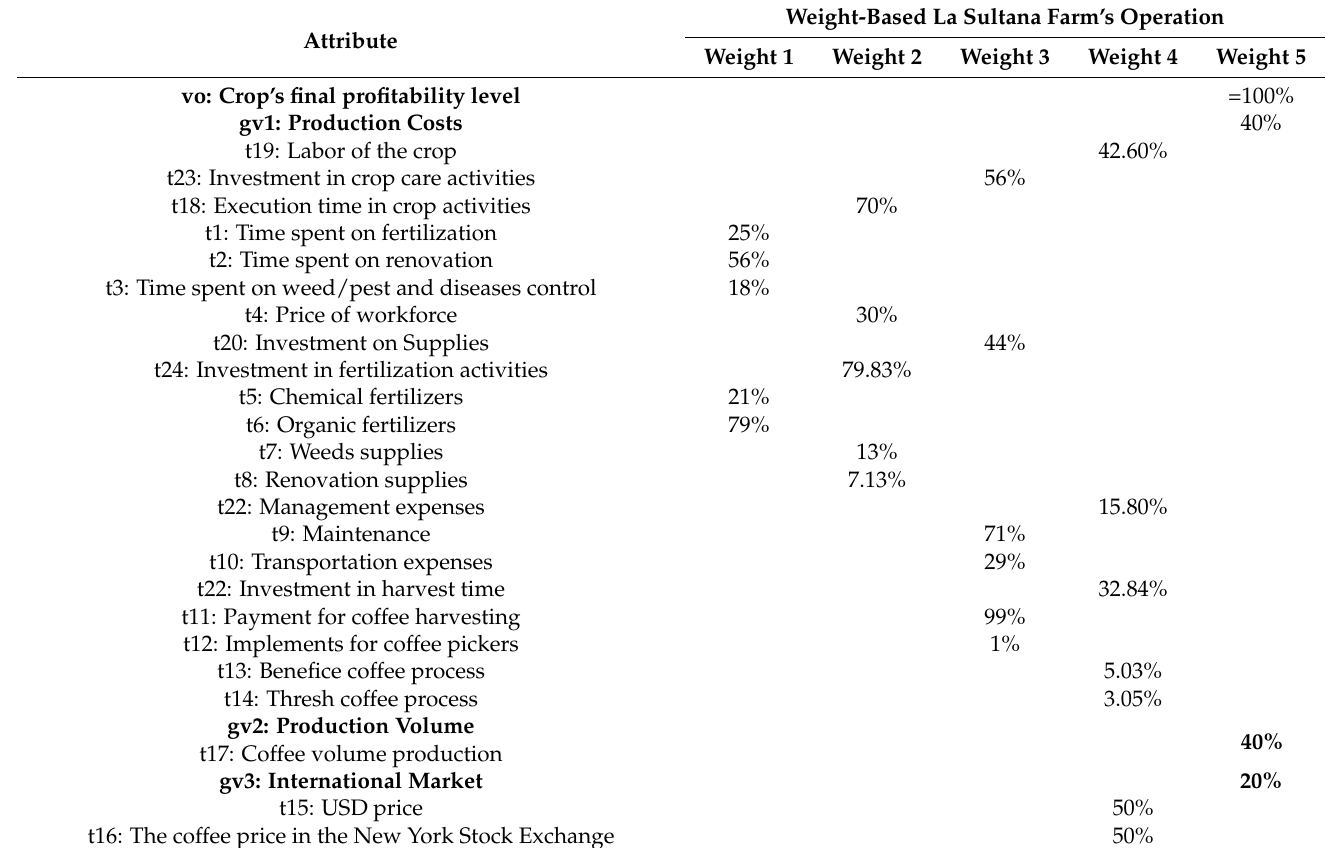
Table 5. Weights defined for the set of HPM-Coffee attributes. The Attribute column contains the basic attributes, aggregate attributes, and output variable. The Weight column includes five weights levels for attributes of the HMP-coffee model. Weight-Based La Sultana Farm’s Operation Attribute Weight 1 Weight 2 Weight 3 Weight 4 Weight